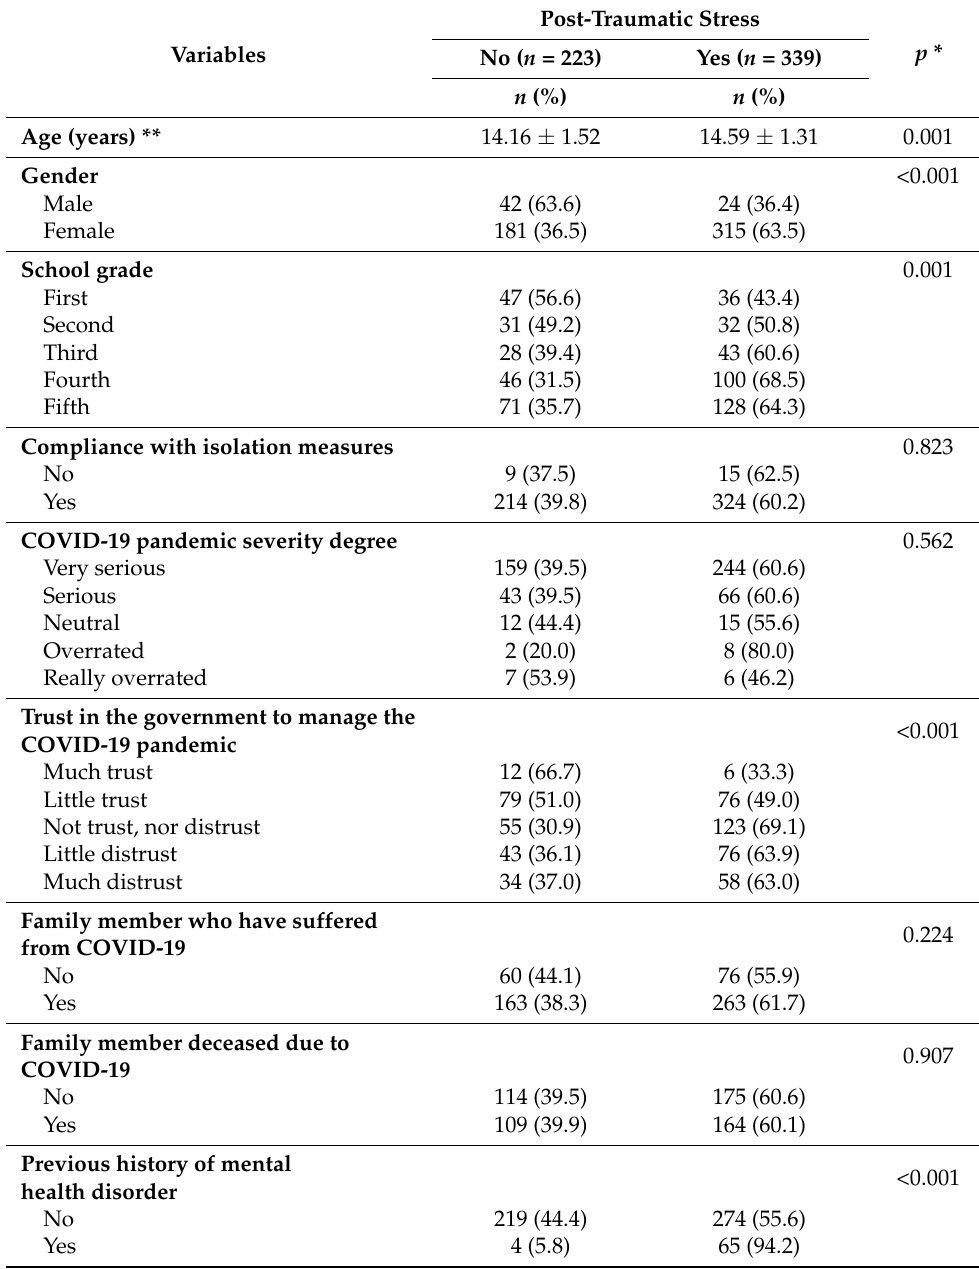
Table 2. Factors associated with post-traumatic